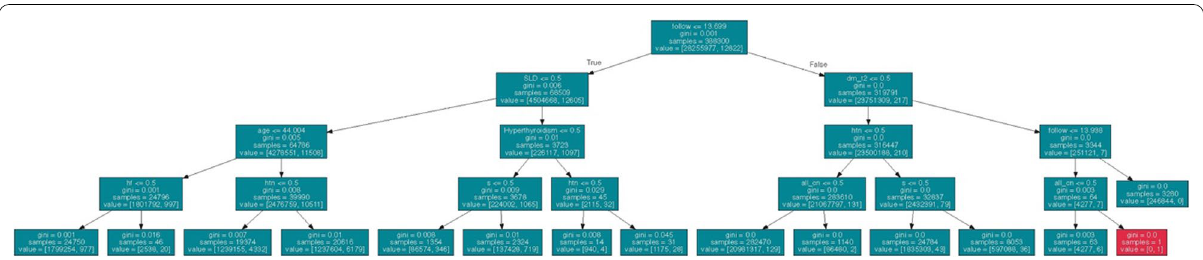
Fig. 1 First decision tree of the random forest model predicting risk of atrial fibrillation